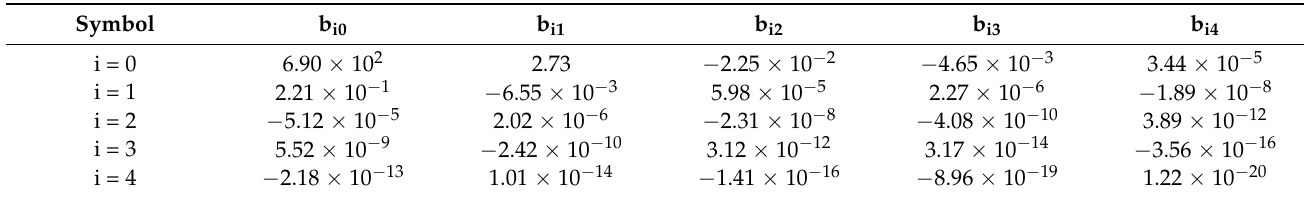
Table A2. Value of correlation coefficients b i 0 ∼ b i 4 (P > 20.69